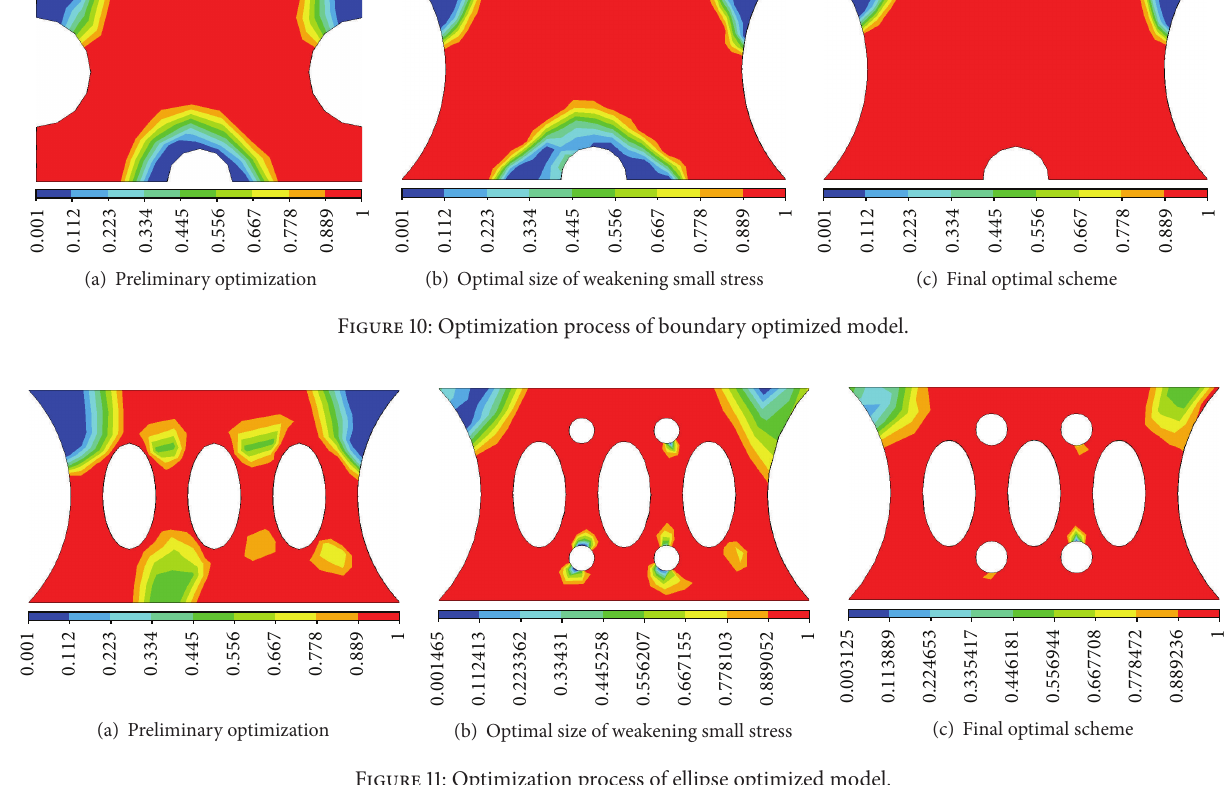
Figure 11: Optimization process of ellipse optimized